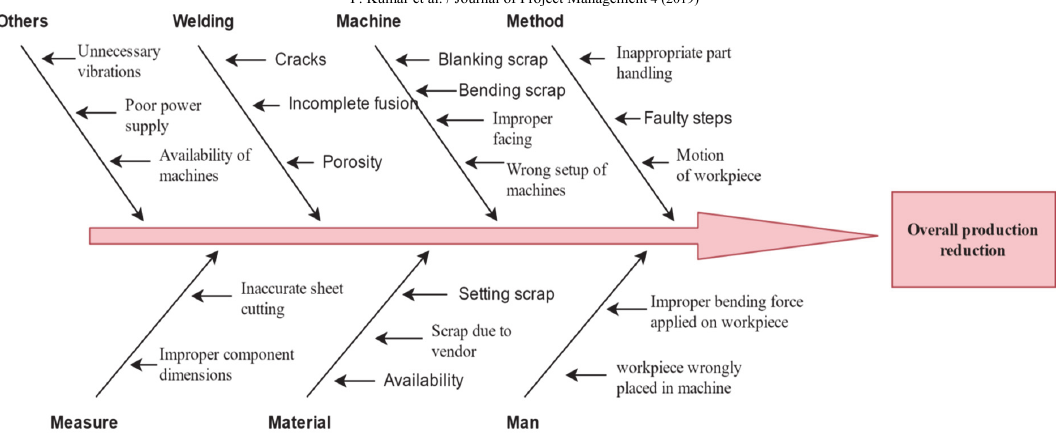
Fig. 2. Cause-and-effect diagram